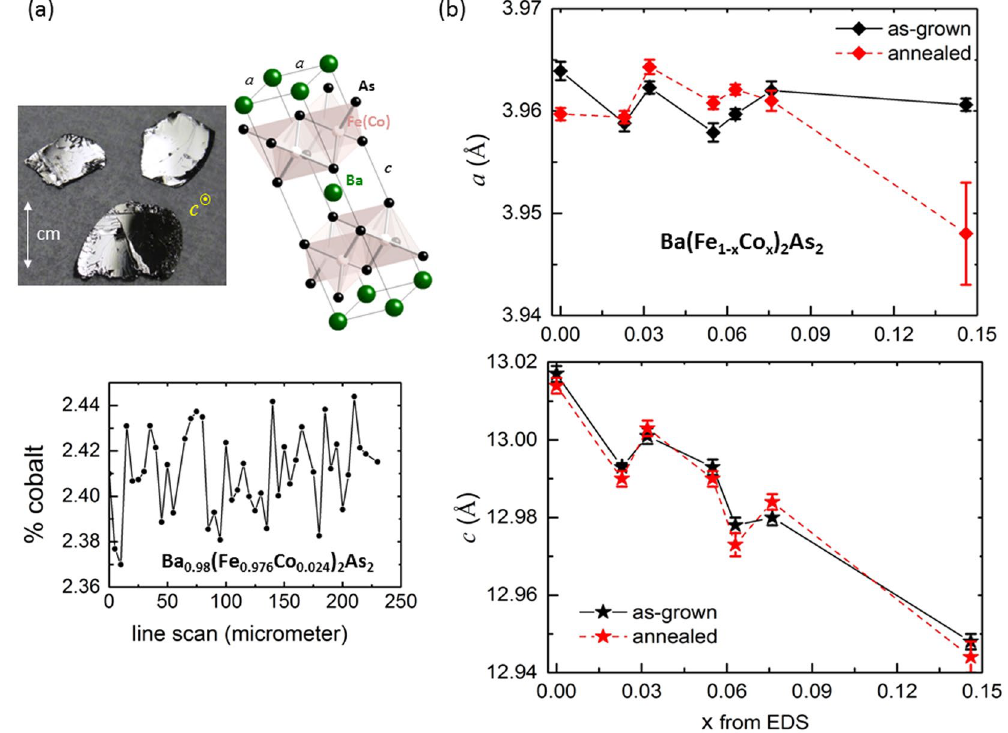
Figure 1. Small variations of cobalt concentrations within a crystal, and changes in a -lattice parameters with annealing of Ba(Fe 1 − x Co x ) 2 As 2 crystals. ( a ) (Top) Typical size and quality of as-grown Ba(Fe 1 − x Co x ) 2 As 2 crystals, and room-temperature tetragonal crystal structure of Ba(Fe 1 − x Co x ) 2 As, with unit cell shown in solid black line; (Bottom) A line scan across a crystal with average composition of Ba 0.98 (Fe 0.976 Co 0.024 ) 2 As 2 , assuming full occupancy of layers. ( b ) The refined a - and c -lattice parameters at room temperature, from powdered crystals with doping levels (x). The level of x does not change upon annealing, within